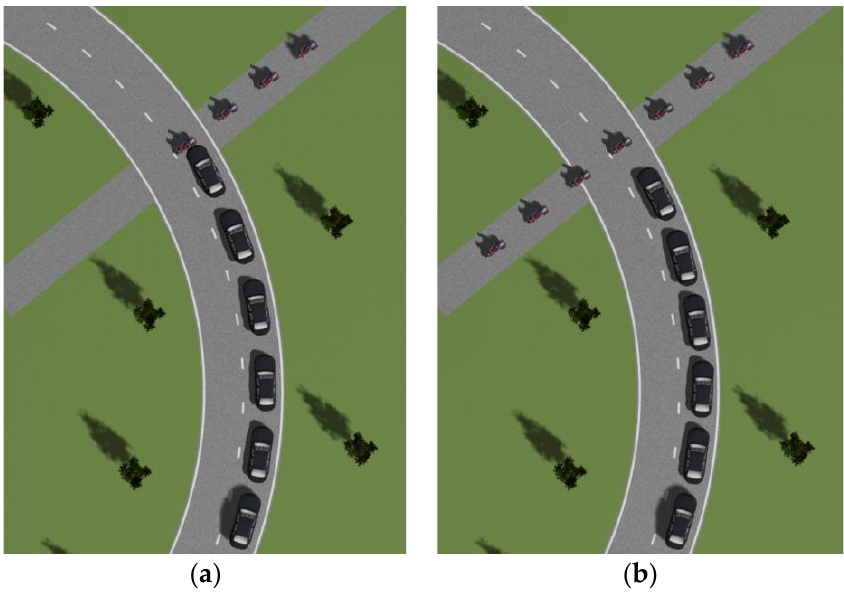
Figure 7. ( a ) Without an active braking system; ( b ) With an active braking system.